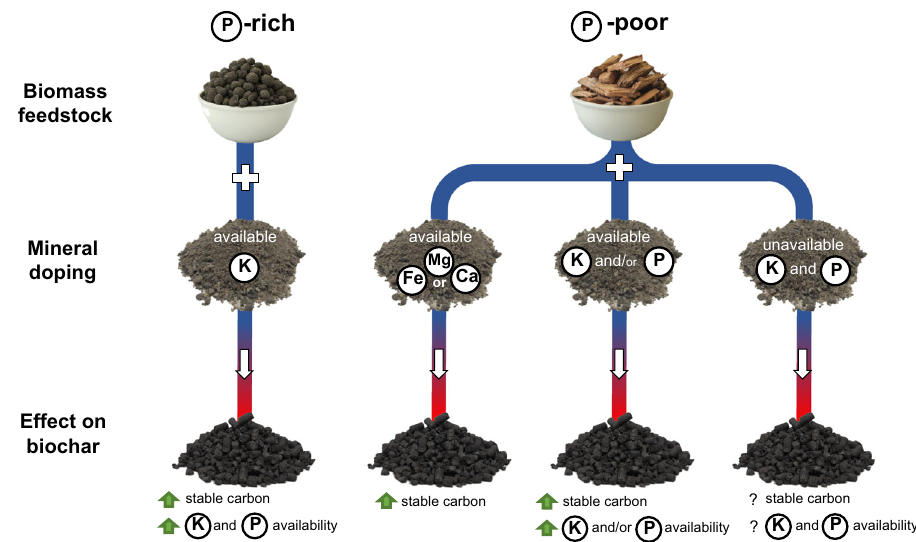
Fig. 2 Effect of mineral addition to P-rich and P-poor biomass on biochar stable carbon yield and availability of P and K in the resulting biochar. Various scenarios are assumed with minerals containing available K, available Fe, Mg, and Ca and available K or P. In the last scenario the addition of minerals containing both unavailable K and P is displayed with uncertain outcomes on stable carbon yield and K and P availability in the biochar.